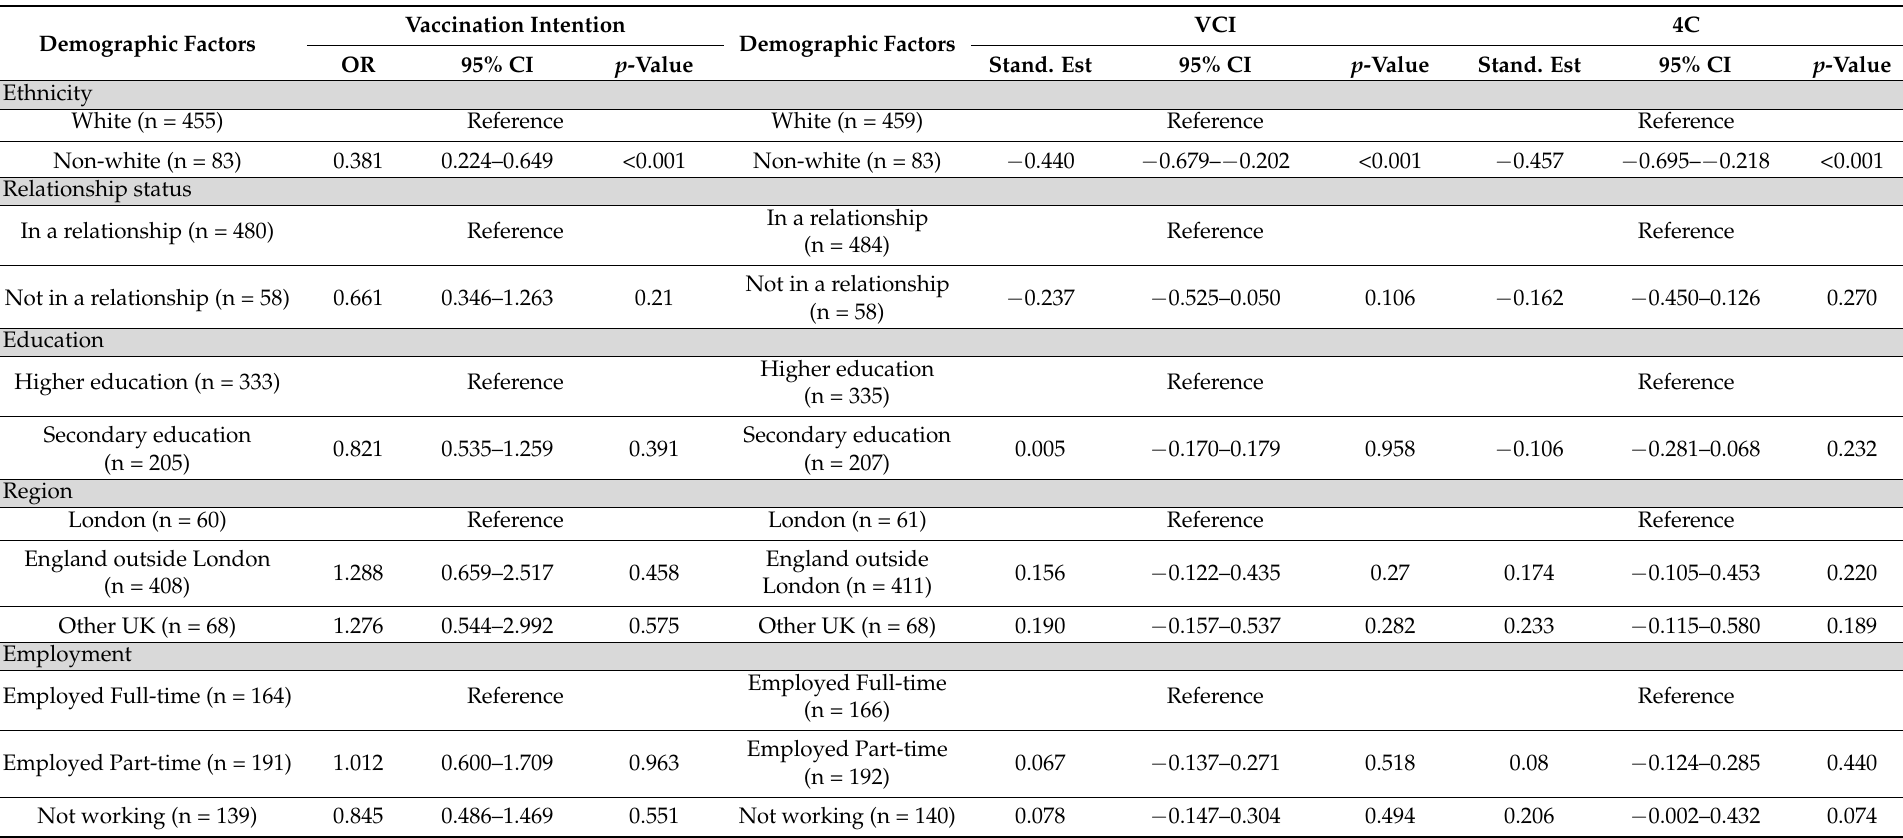
Table 1. Logistic of demographics on (i) vaccination intention (n = 538) and multinomial linear regression of demographics on (ii) Vaccine Confidence Index